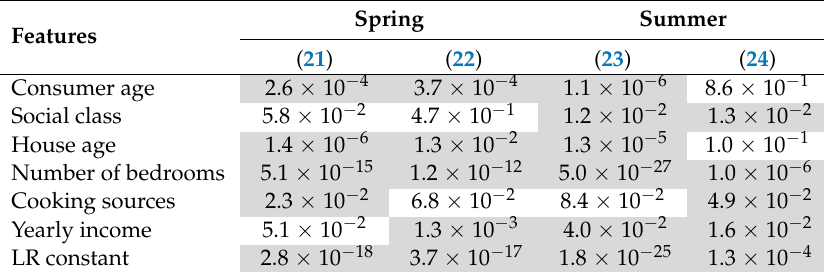
Table 7. p -values of the LR coefficients associated with the key features of Equations (21)–(24), where the p -values < 0.05 are highlighted in grey